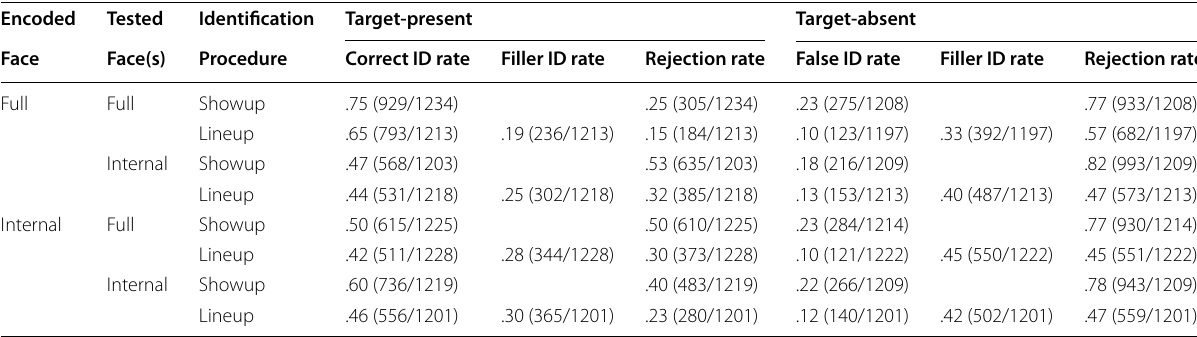
Table 5 Counts and proportions for each decision category of the identification procedures